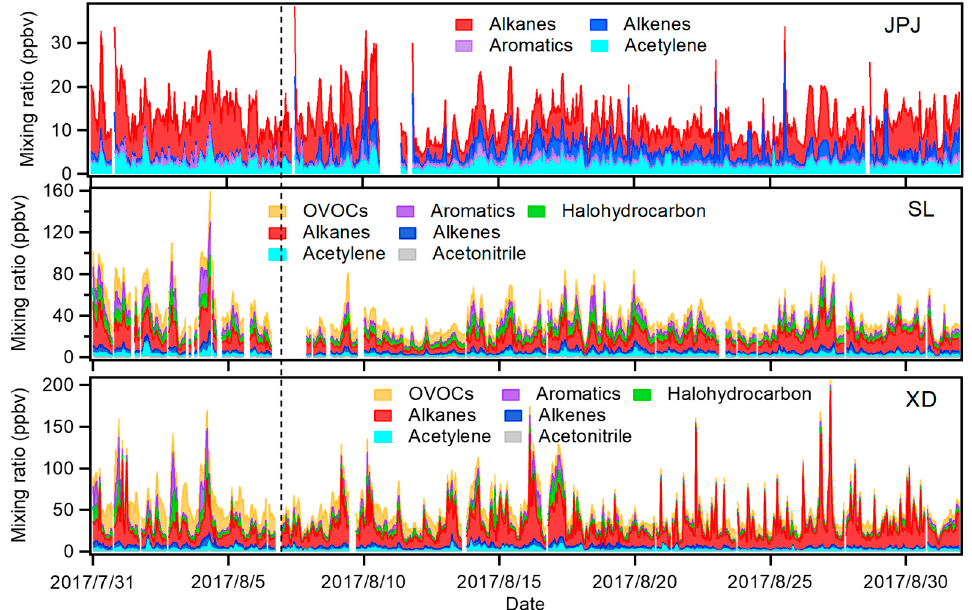
Figure 4. Time series of volatile organic compounds (VOCs) observed at three monitoring sites in Chengdu; the dashed line represents when the control strategy was implemented.